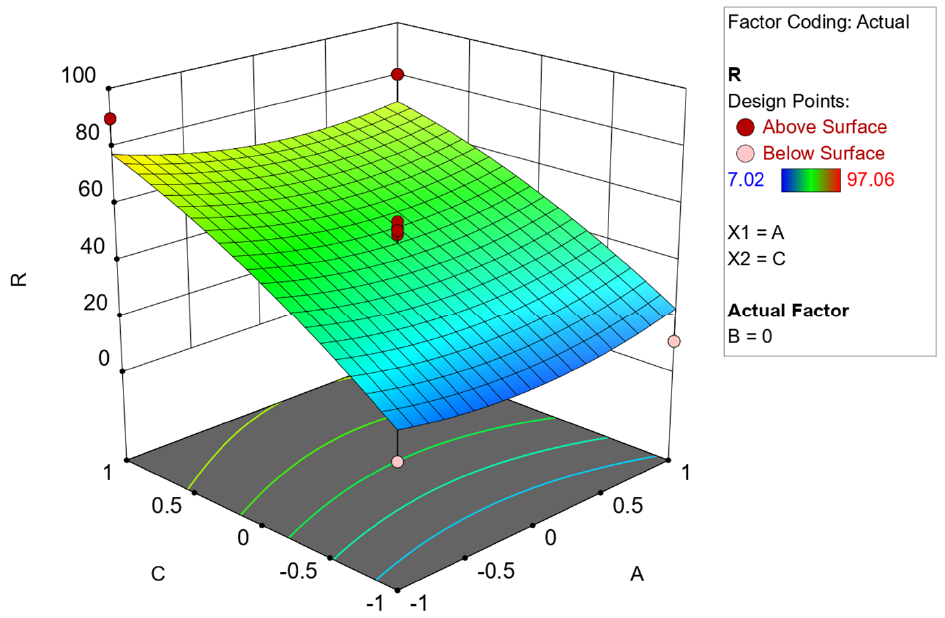
Figure 10. Response surface plot showing the interaction and influence on of the adsorbent mass (A) and contact time (C) on the adsorption rate (R).